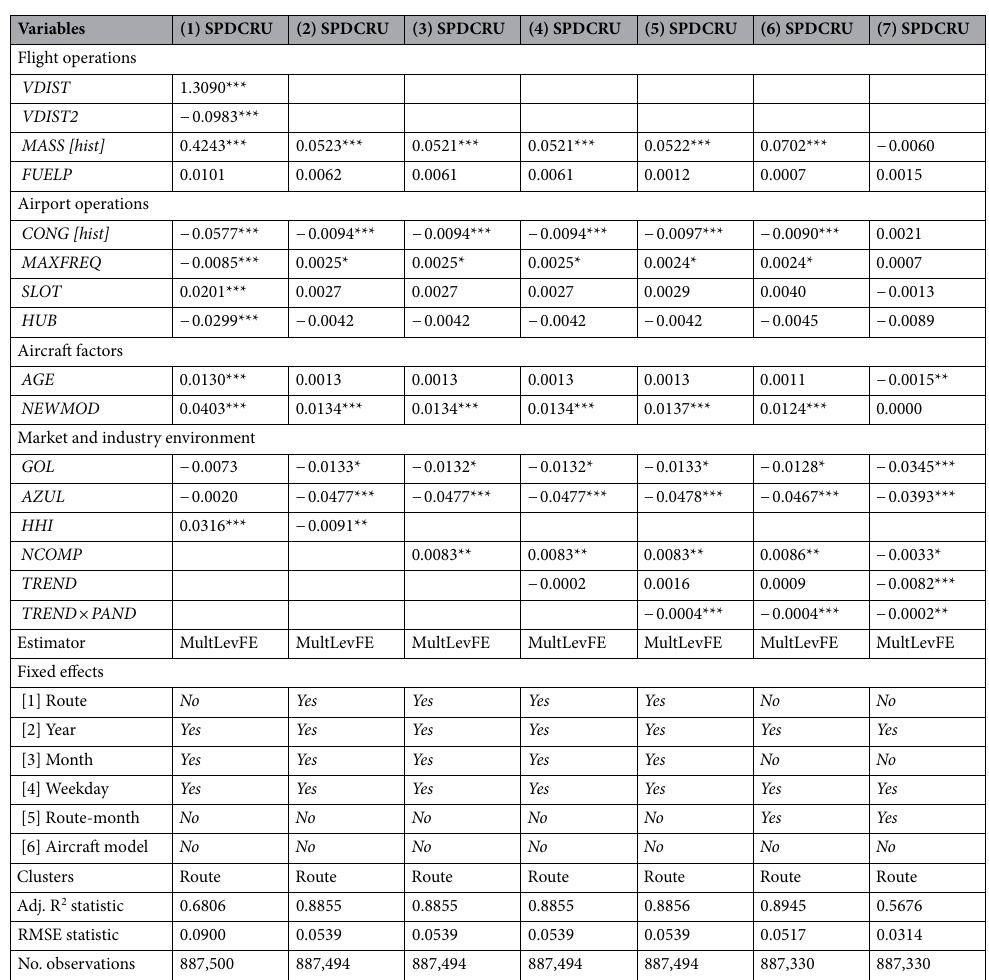
Table 1. Estimation results: flight planned cruise speed ( SPDCRU , DSPDCRU ). Results produced by linear regression absorbing multiple levels of fixed effects (MultLevFE) of Correia 37 . Std. errors adjusted for route clusters. The no. of observations across columns may vary due to singleton drops. p-value representations: ***p < 0.01, **p < 0.05, *p < 0.10. Significant values are in